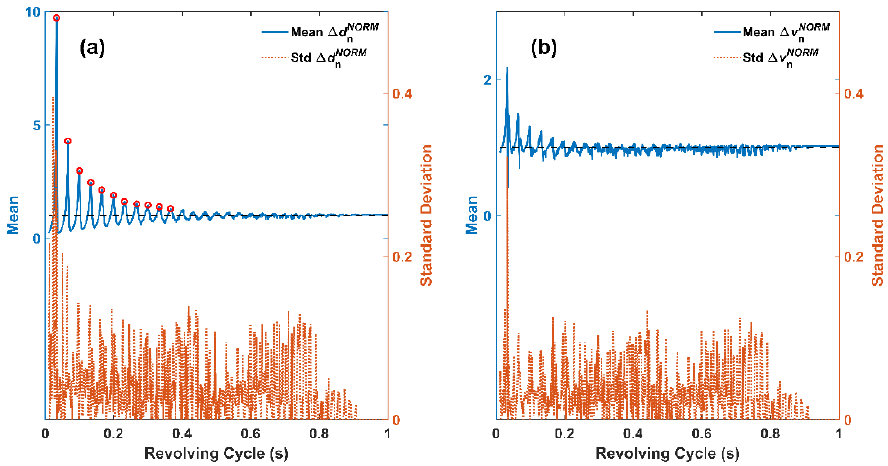
Figure 4. Mean and standard deviation of ( a ) displacement and ( b ) velocity versus revolving cycle. Table 1. Dotted decreasing peaks in the oscillating mean Δ d n NORM curve in Figure 4a. Revolving Cycle T